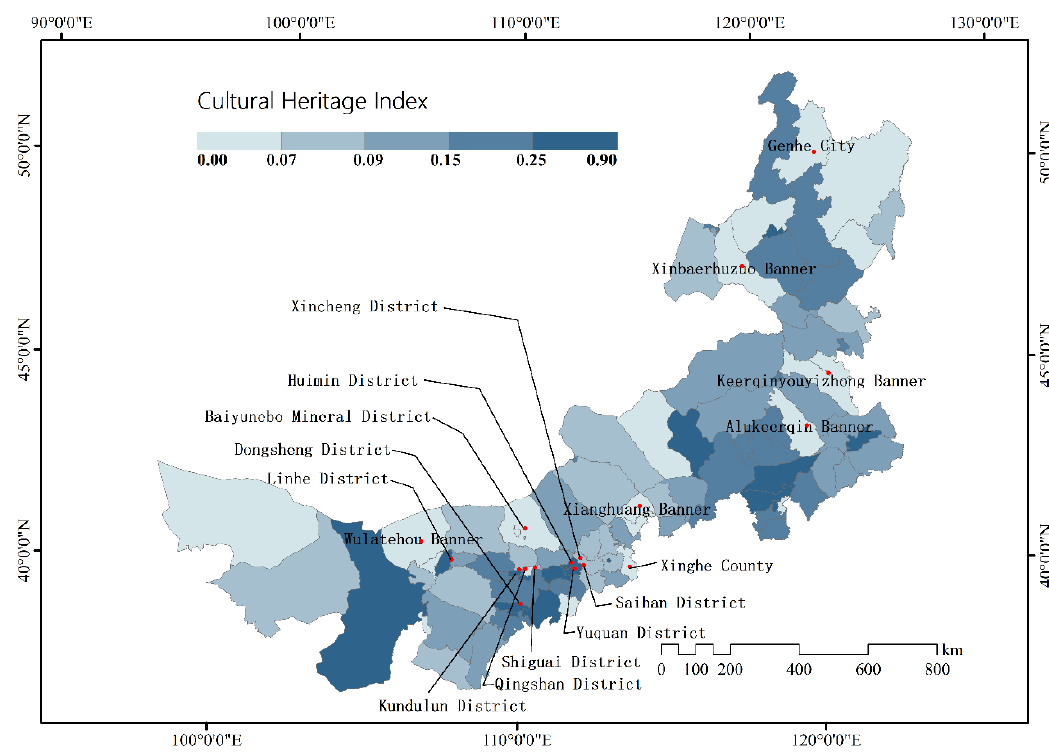
Figure 5. Spatial distribution of the cultural heritage index in Inner Mongolia in 2020.